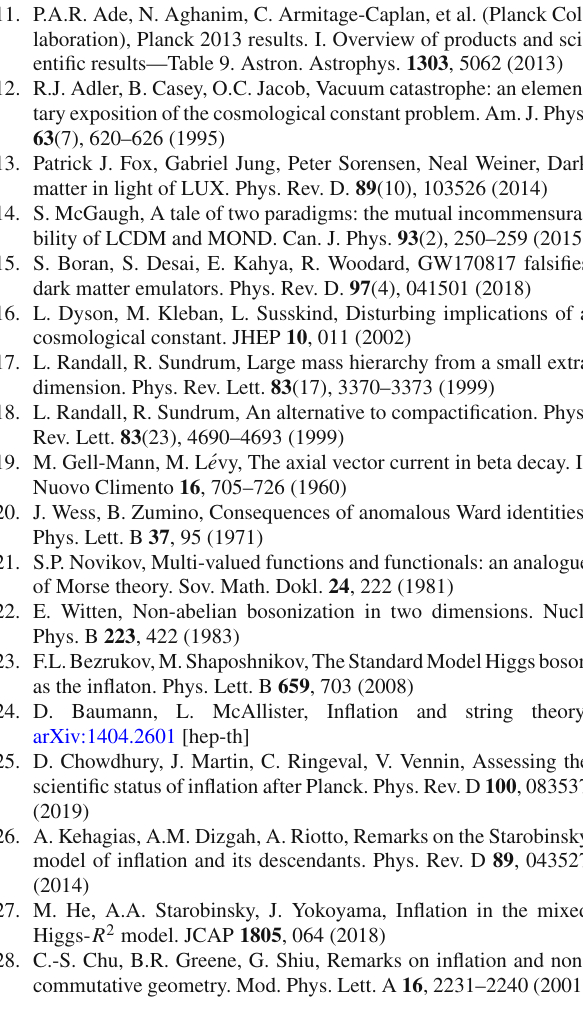
entific results—Table 9. Astron. Astrophys. 1303 , 5062 (2013) 12. R.J. Adler, B. Casey, O.C. Jacob, Vacuum catastrophe: an